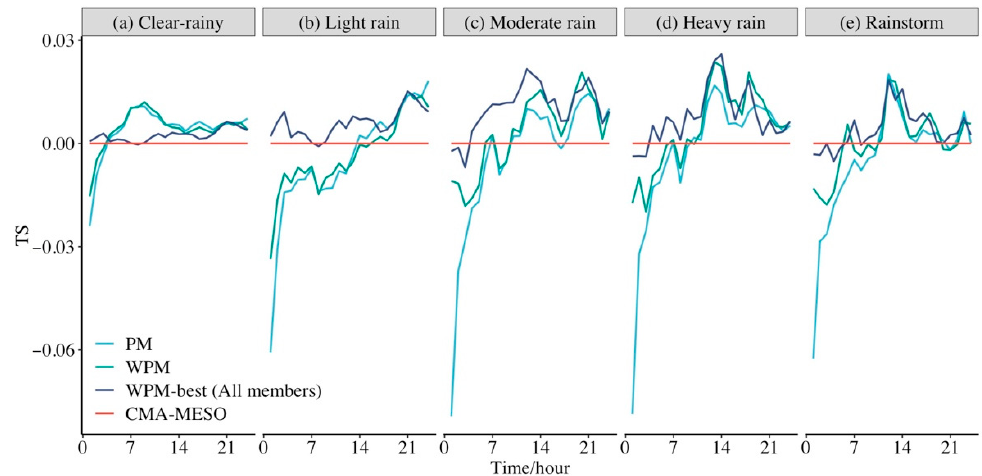
Figure 7. Difference of hourly TS between calibrations and CMA-MESO in valid time of 0–24 h.